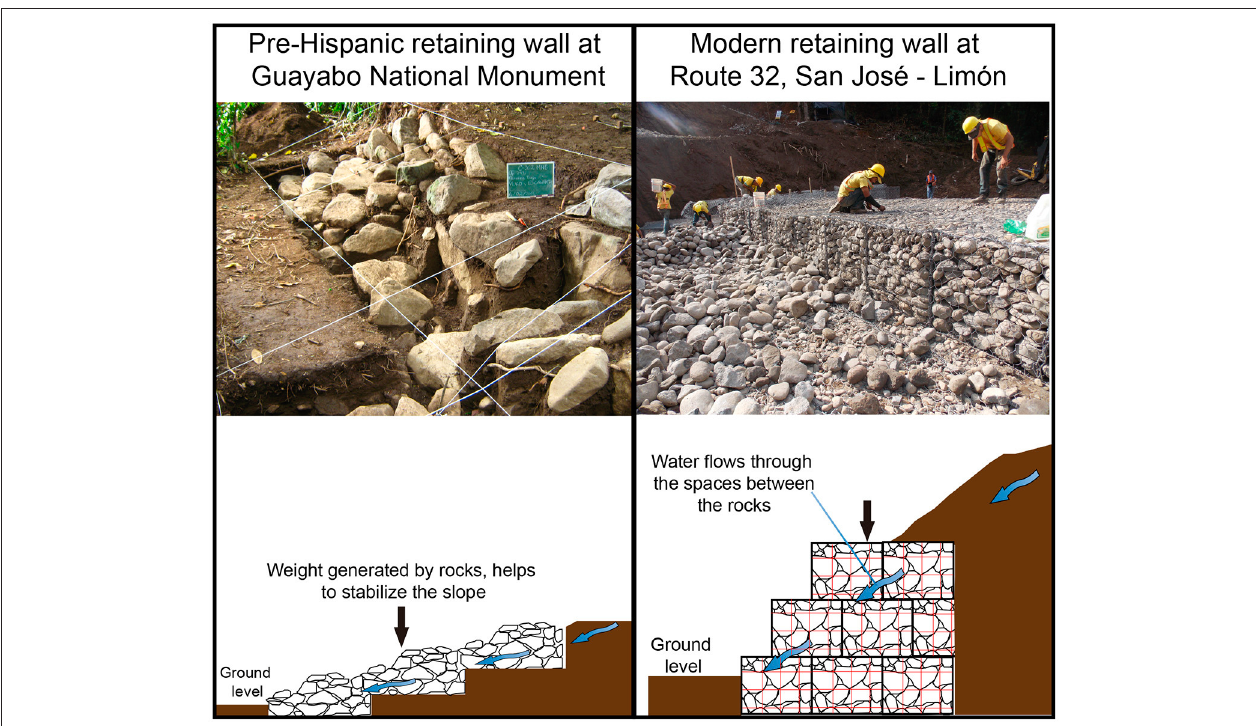
FIGURE 6 | Comparison between pre-Hispanic (“pre-gabions”) and modern gabions. During pre-Hispanic times the retaining walls were built with blocks selected from the river areas. These prevented soil erosion by optimizing surface water flow. Similarly to modern retaining walls, they helped to maintain slope stability by letting water pass while adding weight to the ground on the foot of the